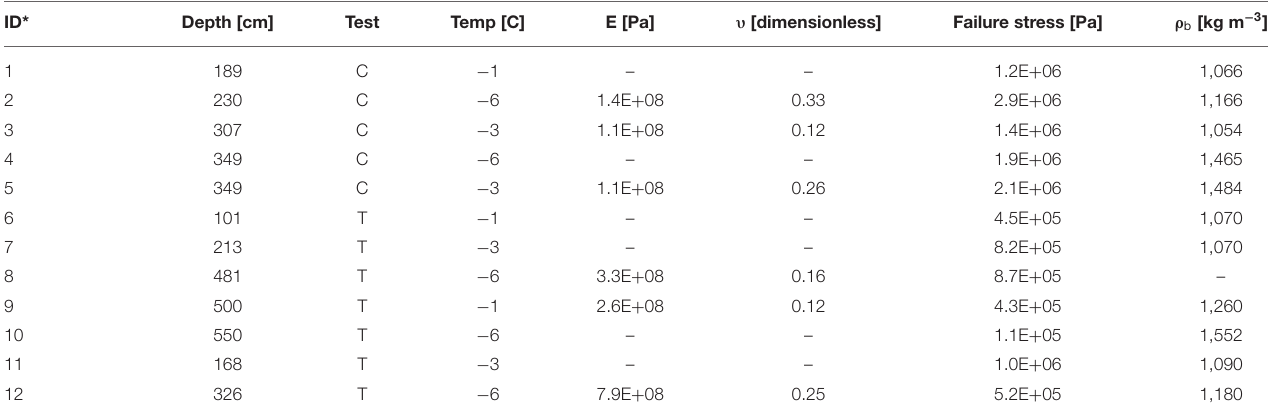
TABLE 2 | Observed permafrost material property values used to inform the parameter ranges in Table 1